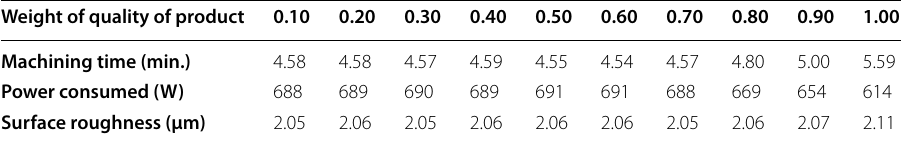
Table 6 Variation of PMS output results with different weights of power factor Weight of power factor 0.10 Machining time (min.) Power consumed (W) 689 Surface roughness (μm)